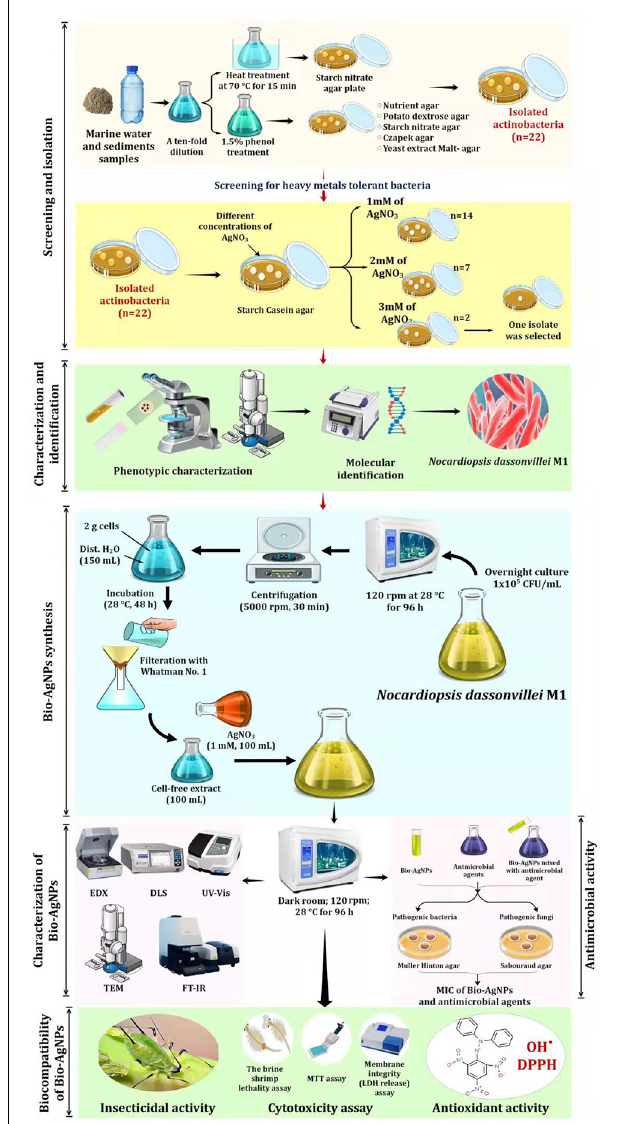
FIGURE 1 | Experimental set up for biosynthesis of silver nanoparticles by marine actinobacterium Nocardiopsis dassonvillei M1 and exploring their therapeutic